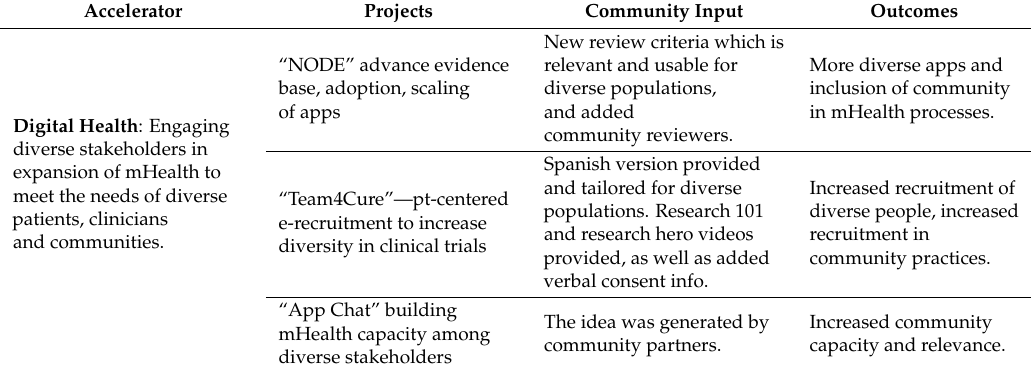
Table 1. Accelerator activities, community input, and outcomes. NODE: Network of Digital Evidence. Accelerator Projects Community Input Outcomes